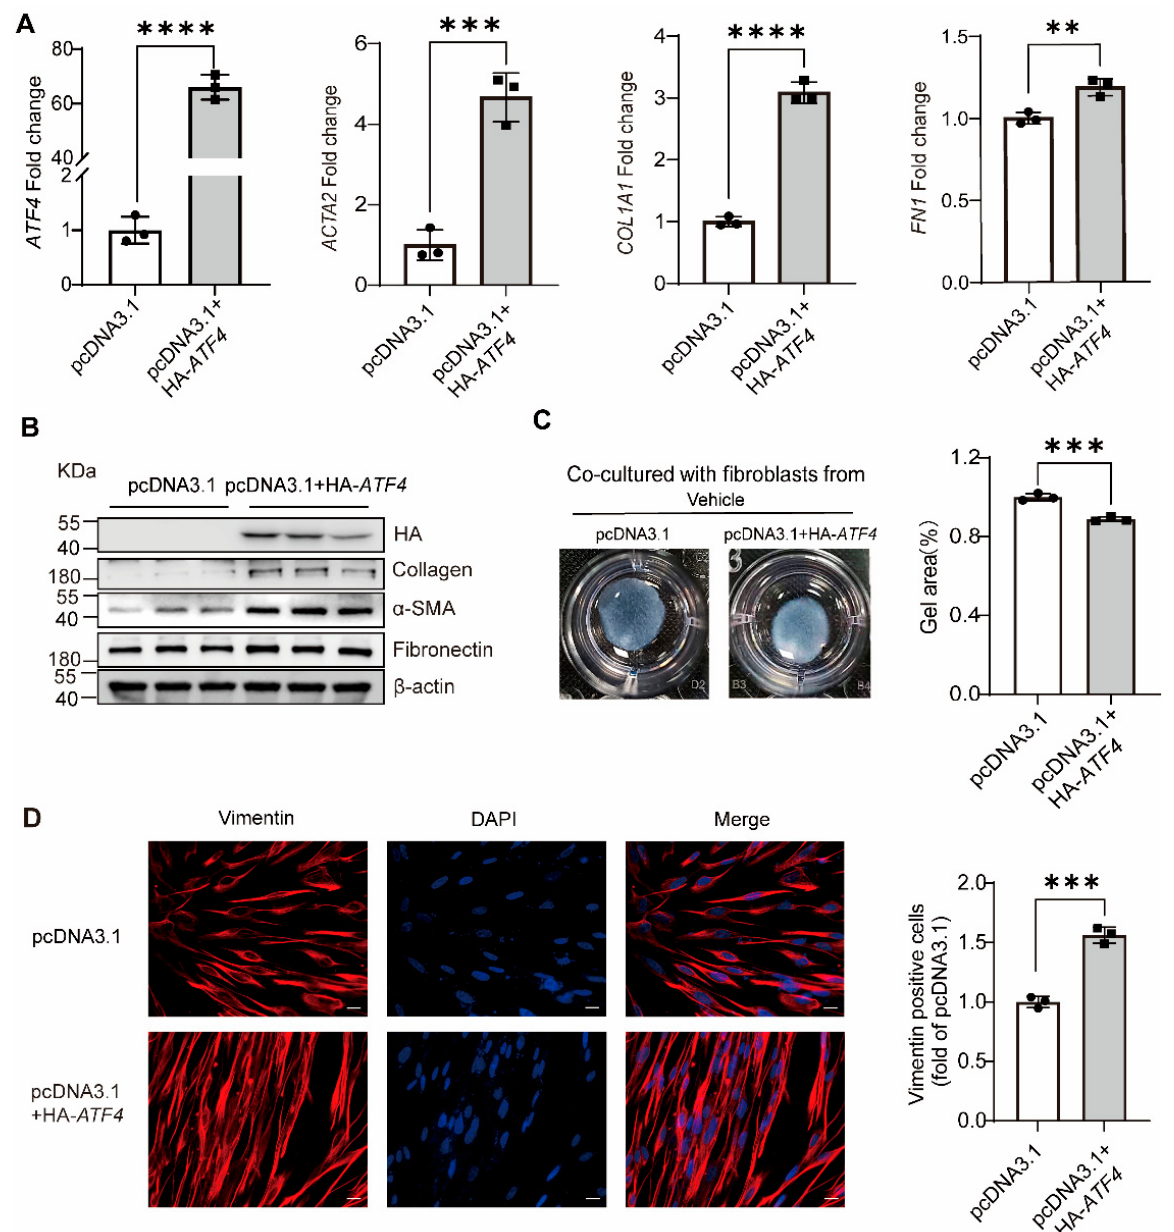
Figure 6. ATF4 promotes lung fibroblast activation. ( A ) qPCR analysis of ATF4 -overexpressing normal fibroblasts (pcDNA3.1+HA- ATF4 ) shows enhanced profibrotic transcript levels compared with normal lung fibroblasts transfected with an empty vector plasmid. The results were analyzed by the unpaired Student’s t -test for comparisons between two groups with normal distribution. Data are presented as mean ± SD. ** p < 0.01, *** p < 0.001, and **** p < 0.0001. ( B ) HA-tagged ATF4 , collagen I, α -SMA, fibronectin, and β -actin proteins were detected by western blot (N = 3 independent experiments). ( C ) The activation of fibroblasts was examined based on fibroblast contraction in 3D collagen matrices (N = 3 independent experiments). We used ImageJ software to measure the area of gels. The results were analyzed by the unpaired Student’s t -test for comparisons between two groups with normal distribution. Data are presented as mean ± SD. *** p < 0.001. ( D ) MRC5 cells were subjected to immunofluorescence with a vimentin antibody. Scale bars, 20 µ m. ImageJ software was used to quantify the fluorescence intensity. The results were analyzed by the unpaired Student’s t -test for comparisons between two groups with normal distribution. Data are presented as mean ± SD. *** p <